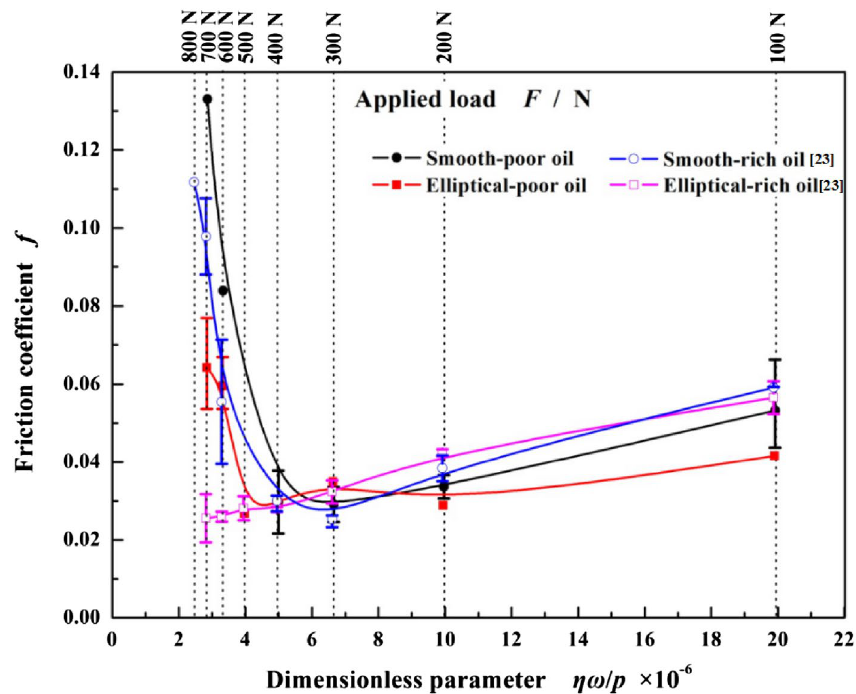
Figure 6. Friction coefficients of smooth and elliptical dimpled surfaces with the increase of dimensionless parameter under rich 23 and poor lubrication conditions ( η is the viscosity of the lubricant, p , the load per unit area and ω , the rotational speed).